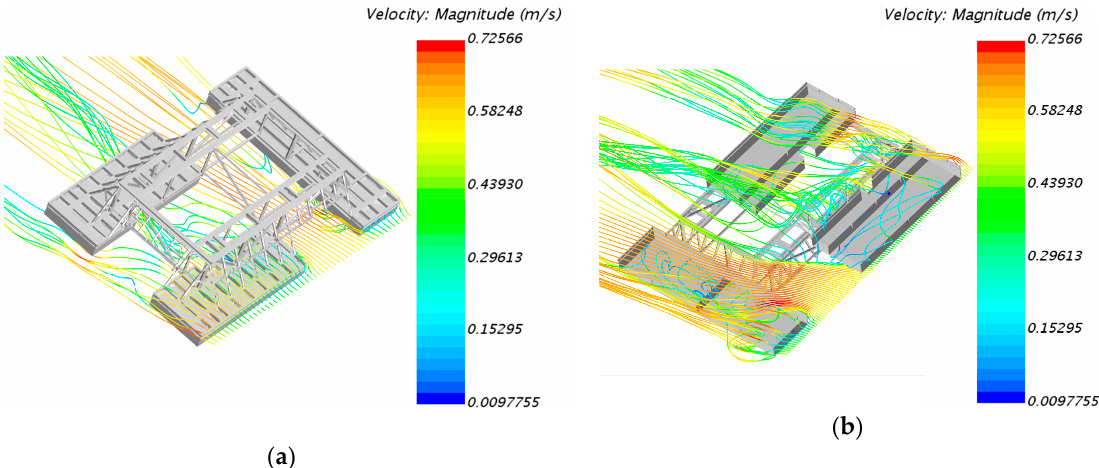
Figure 17. Plan view of streamlines from the inlet section in Case 6: ( a ) top of the flow field, ( b ) bottom of the flow field.